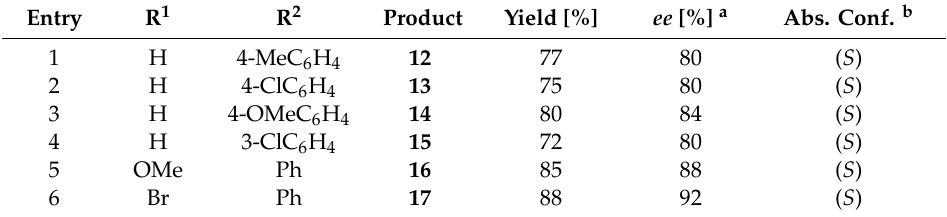
Table 3. Asymmetric Friedel–Crafts alkylation catalyzed by aziridine-phosphines 6 .